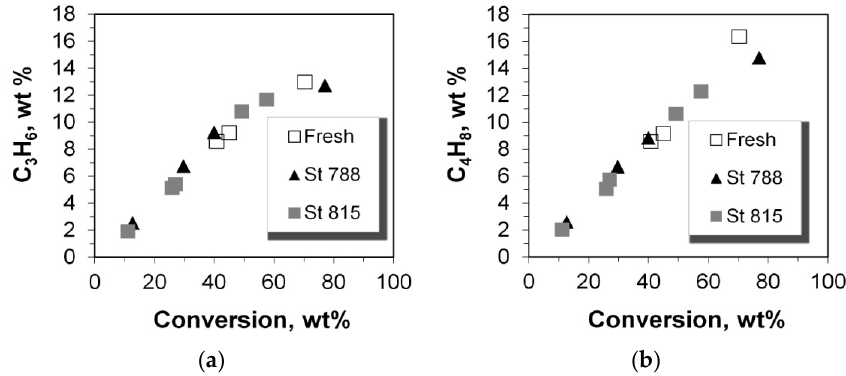
Figure 9: Production yields of ( a ) propylene and ( b ) total butylenes versus the conversion of n-C 12 .